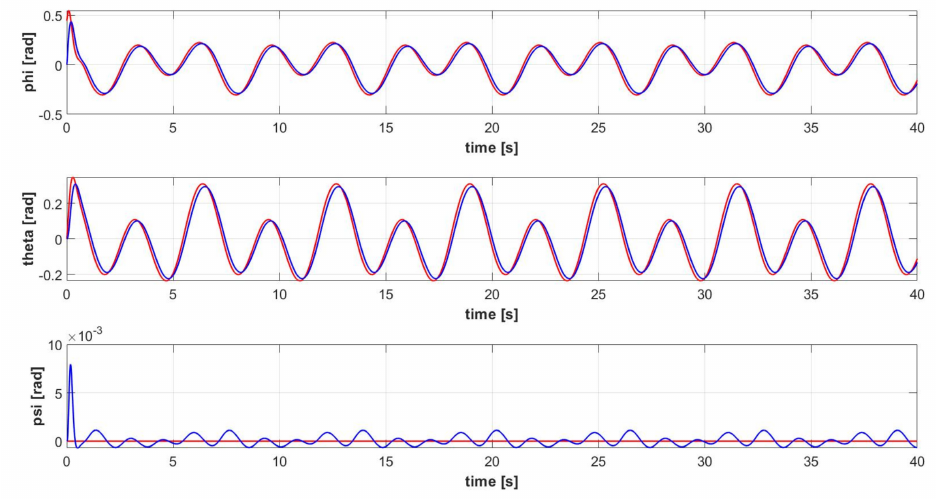
Figure 16. Euler angles signals [ φ ( t ) , ϑ ( t ) , ψ ( t ) ] of the controlled quadrotor system (blue) and reference attitude signals for trajectory 2